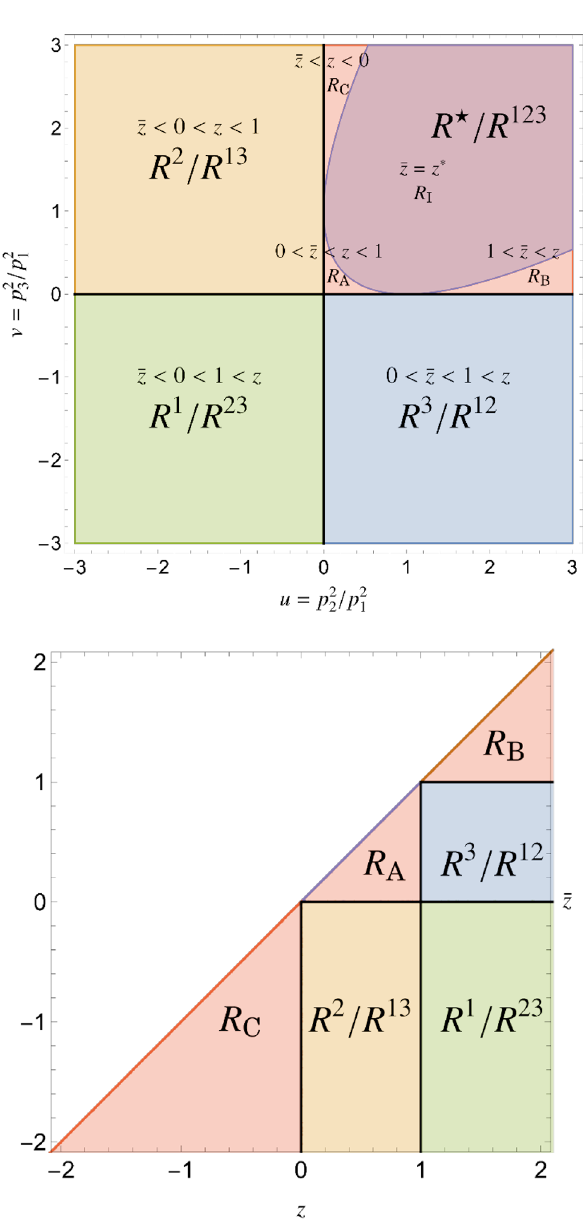
Figure 6 . The triangle ladder integrals we consider depend only on u = p 2 or equivalently on z and ¯ z . The different regions in u, v and z, ¯ z space correspond to regions in which the Mandelstam invariants have different relative signs. For instance, in R 1 the invariants satisfy p 2 > 0 , p 2 < 0 , and p 2 < 0 . The Euclidean region, where p 2 1 2 3 subregions, described in the